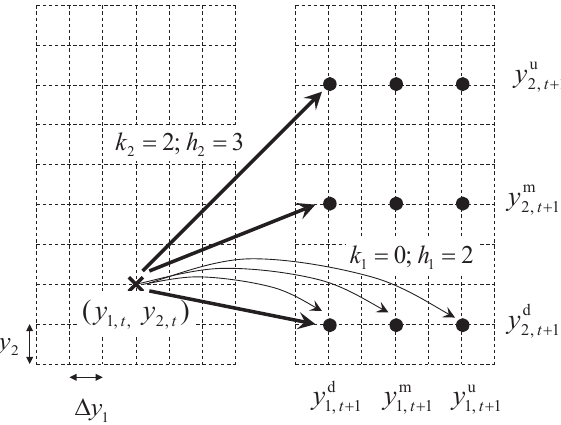
Figure 1. An example of node branching of our proposed two-factor